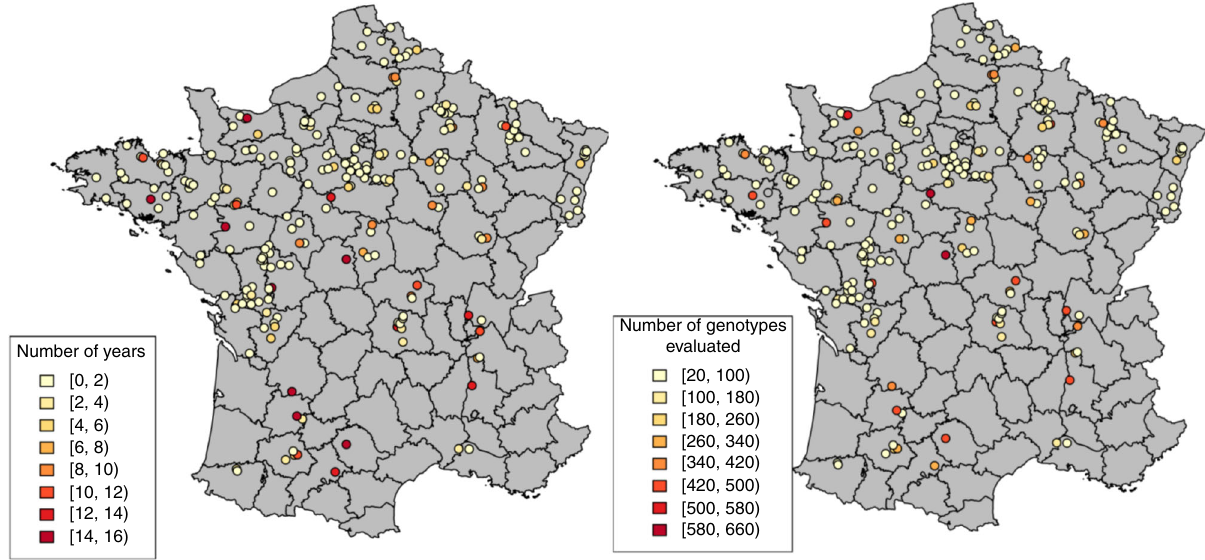
Fig. 2 Network of trials. Each dot represents a trial location; the color scale is used to denote the number of years with records for each location (left) and the number of genotypes tested at each location (right). (Clustering based on minimum temperature, maximum temperature, rain, and total wheat area is shown in Supplementary Fig.